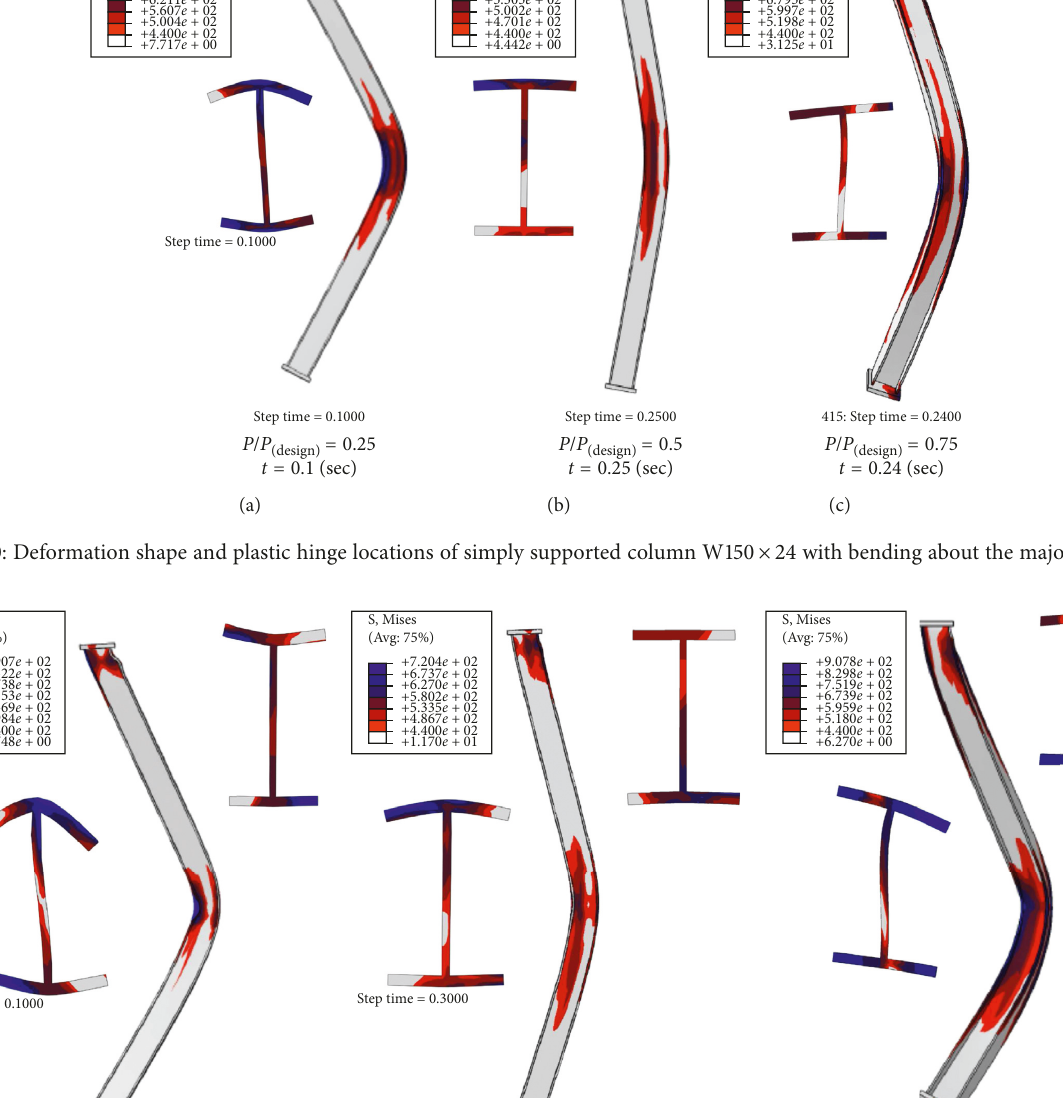
Step time = 0.1000